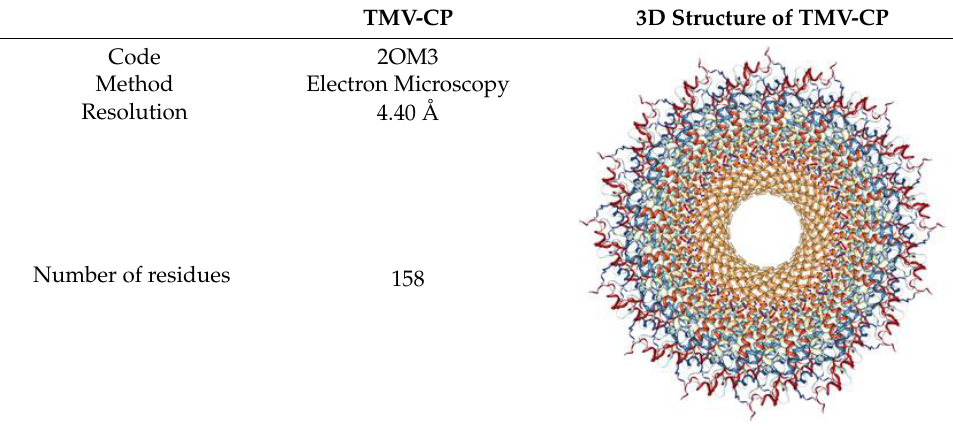
Table 2. Details of the three-dimensional crystal structure (PDB ID: 2OM3) of TMV-CP. TMV-CP 3D Structure of TMV-CP